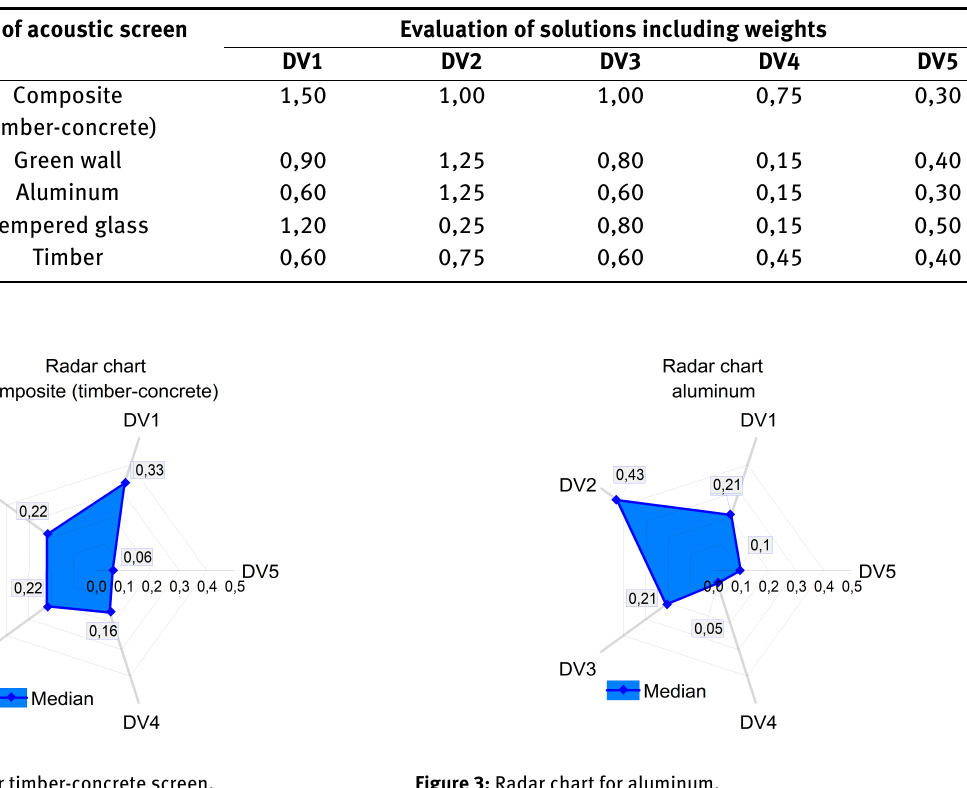
Figure 3: Radar chart for aluminum.